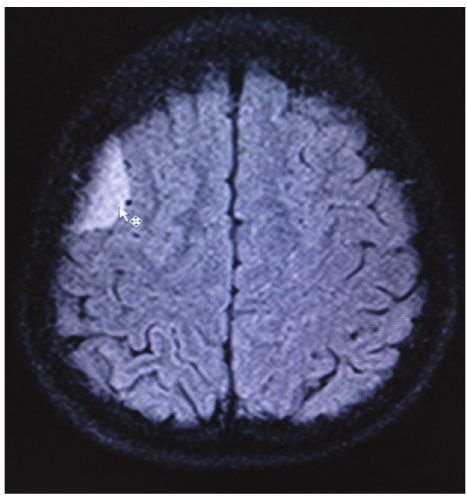
Figure 5: Axial fluid attenuated inversion recovery MR image showing broad dural based extra axial en plaque meningiomas at right frontoparietal region.